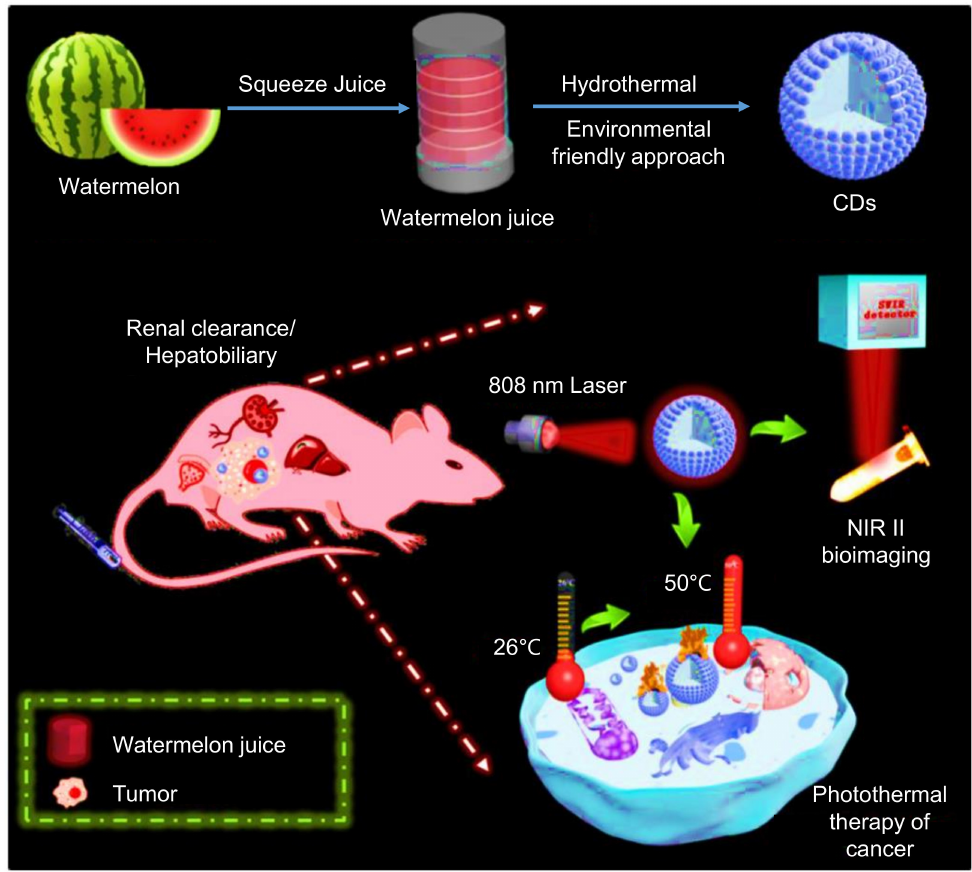
Figure 29. Graphical representation of the preparation of the NIR-II emissive CDs for the photother- mal therapy of cancer, and rapid renal clearance NIR-II bioimaging. Reprinted from [340], with permission from American Chemical Society,